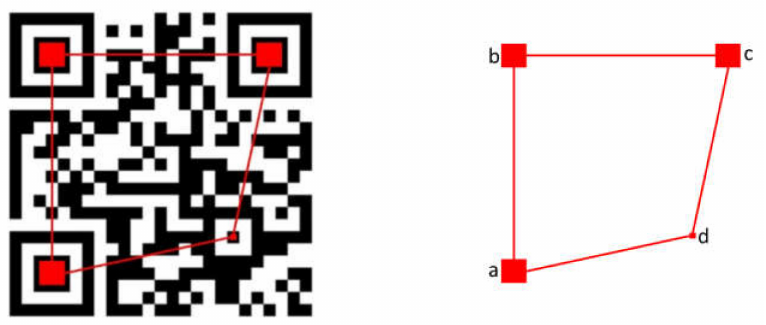
Figure 4. Coordinates of vertices within the QR